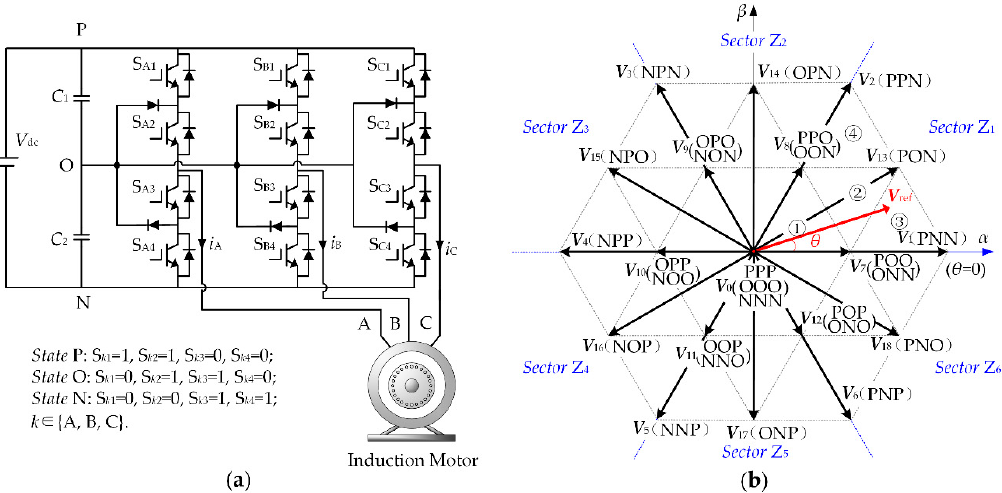
Figure 1. The topology of NPC three-level inverter and the space vector hexagon: ( a ) topology; ( b ) space vector hexagon.